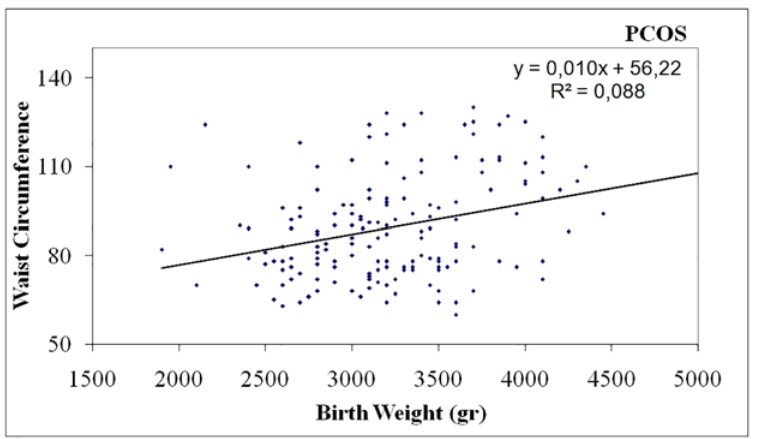
Fig 2. Positive correlation of birth weight with waist circumference in women with